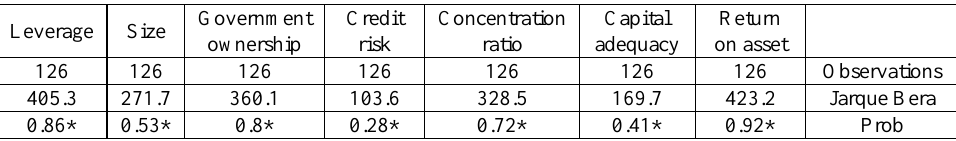
Table 1:Variable's Normality Test